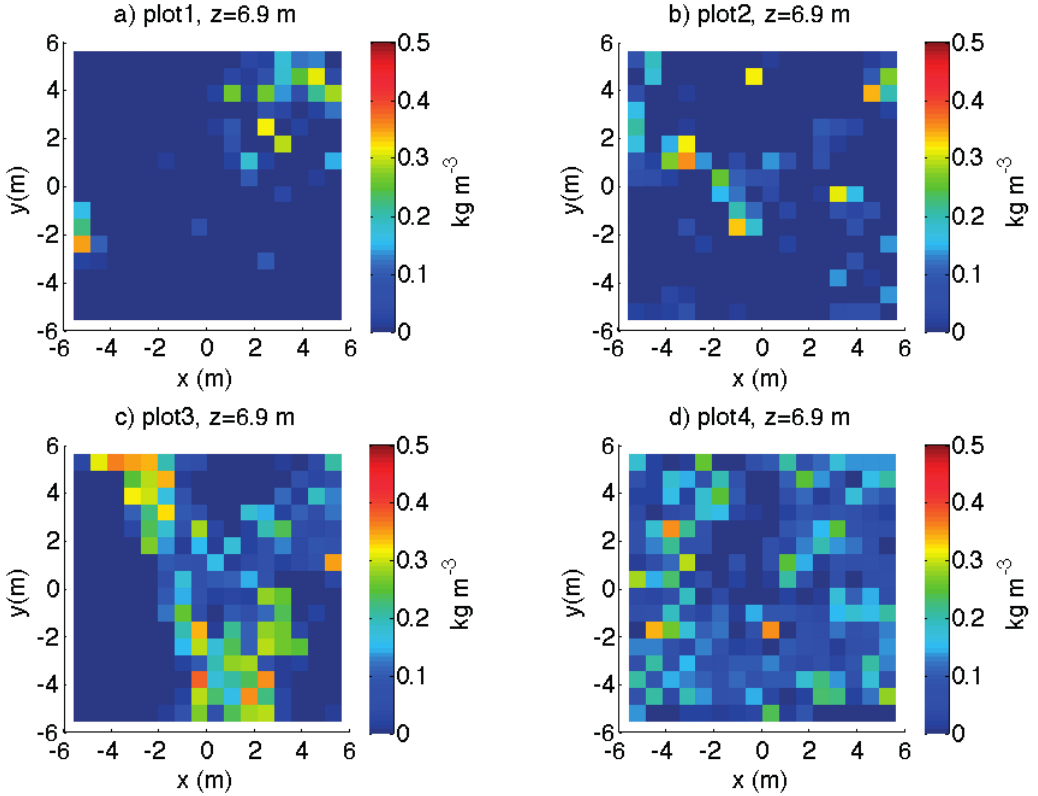
Figure 11. Horizontal leaf bulk density derived from TLS in Plots 1 to 4 at z = 6.9 m: ( a ) Plot 1; ( b ) Plot 2; ( c ) Plot 3 and ( d ) Plot 4. The point (0,0) corresponds to plot